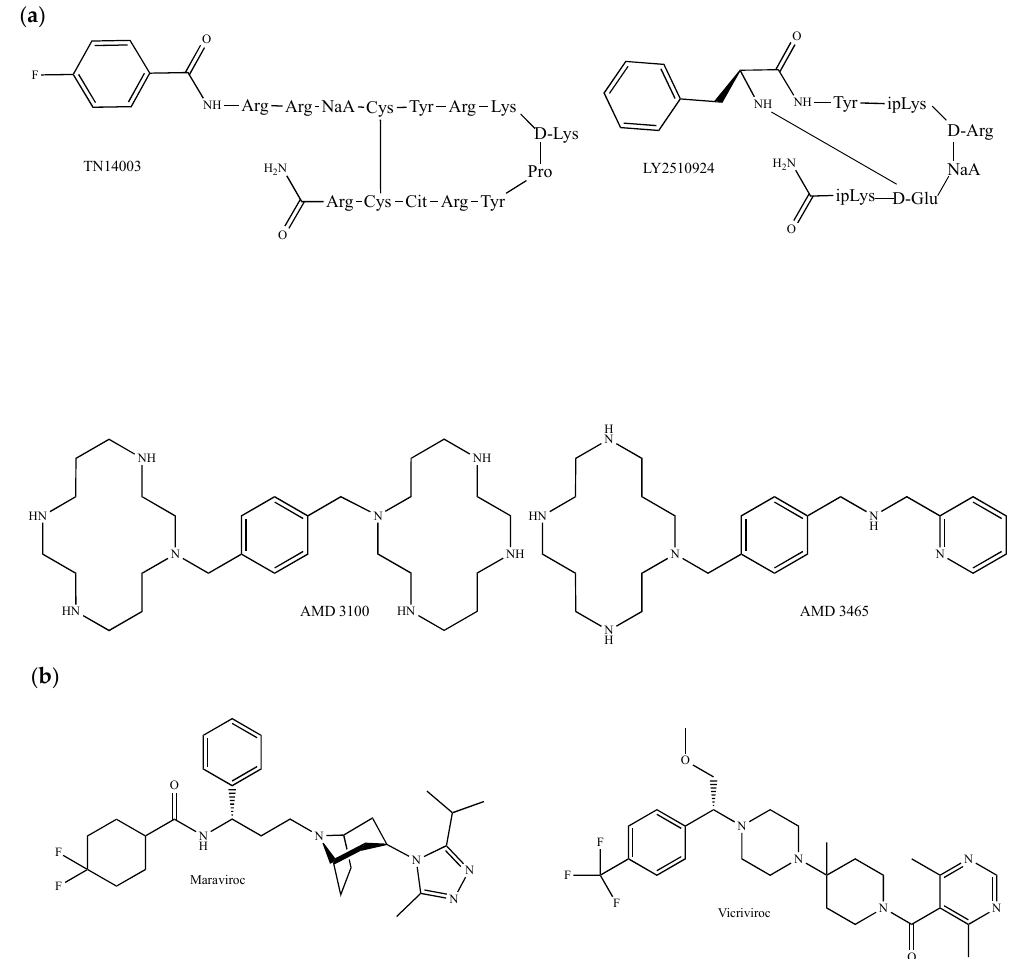
Figure 5. Structure of ( a ) CXCR4 and ( b ) CXCR5 peptidic and heterocyclic inhibitors. NaA and ipLys correspond to L -3-(2-naphtyl)alanine and N -isopropyl- L -lysine, respectively.